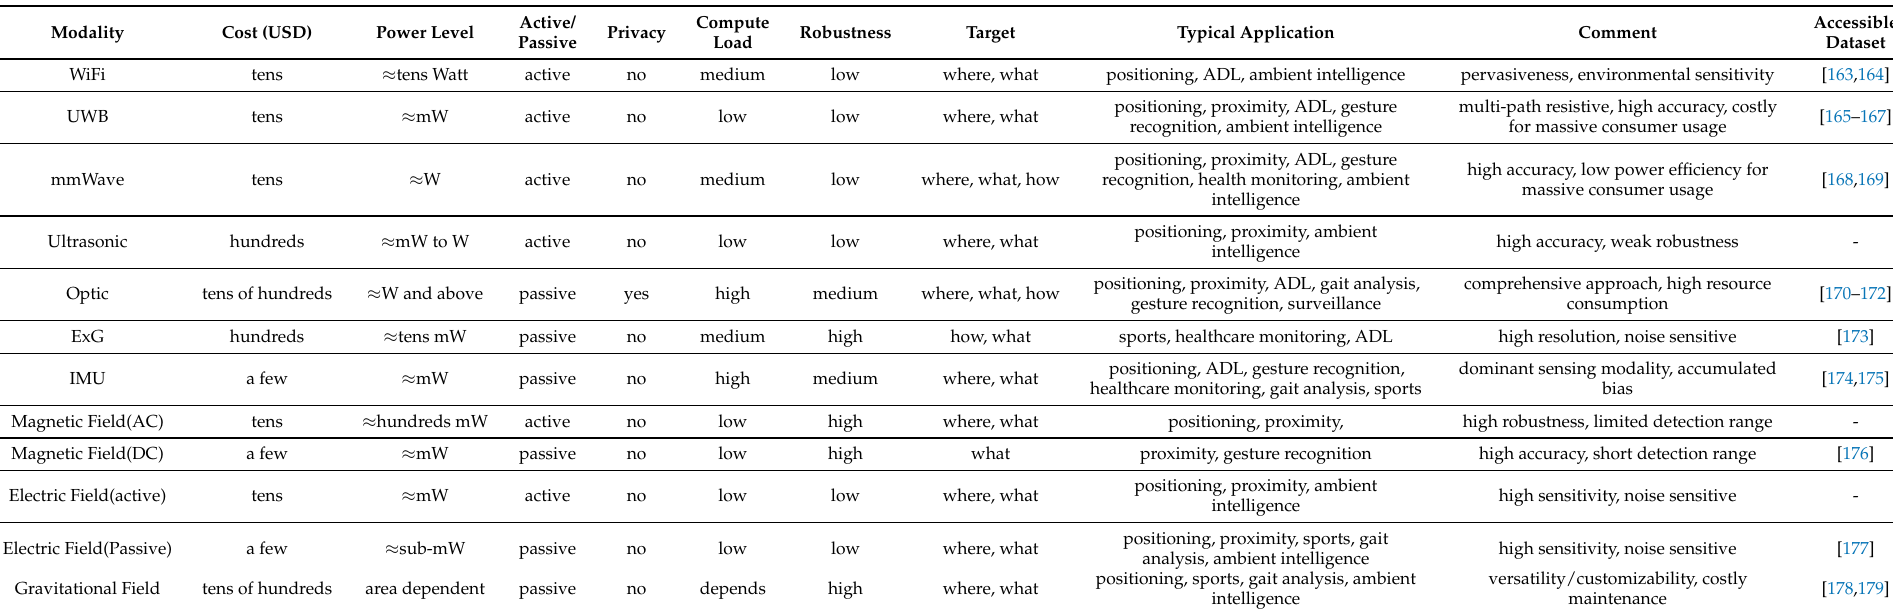
Table 2. Sensing techniques in HAR